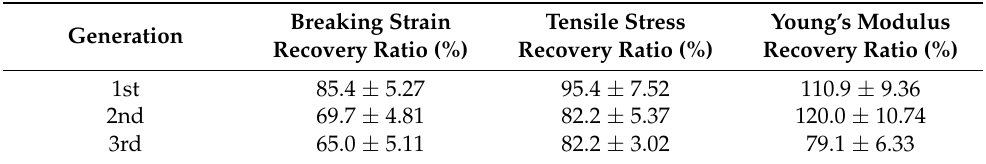
Figure 12. Optical images of shape-memory performance of the semi IPNs 6%CPSFTPU 1 . Table 5. Recovery rate of mechanical properties of samples from different